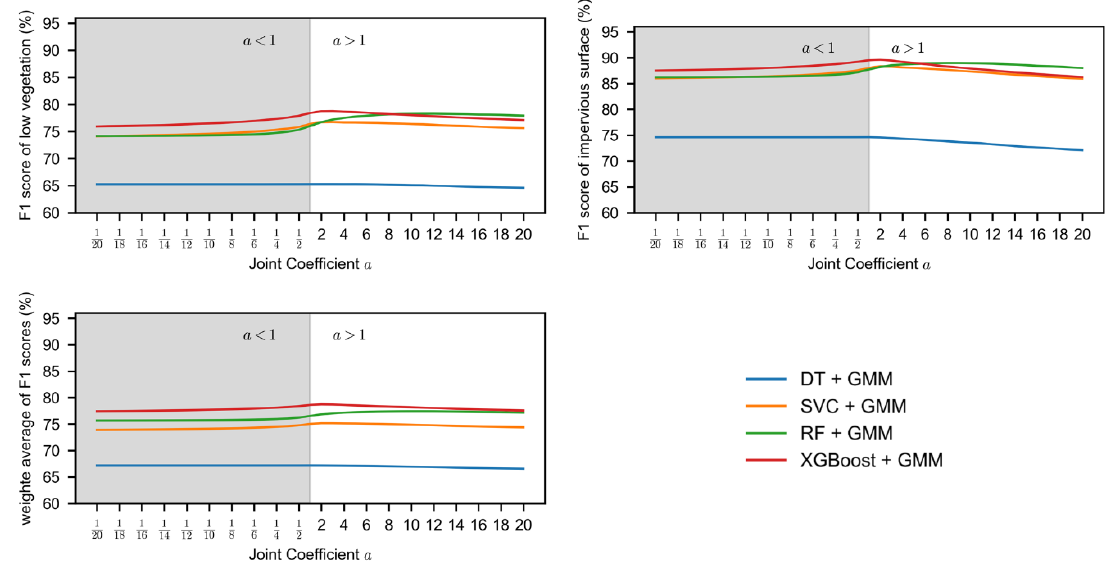
Figure 11. E ff ect of joint coe ffi cient a on the performance of the proposed Figure 11. Effect of joint coefficient a on the performance of the proposed method.